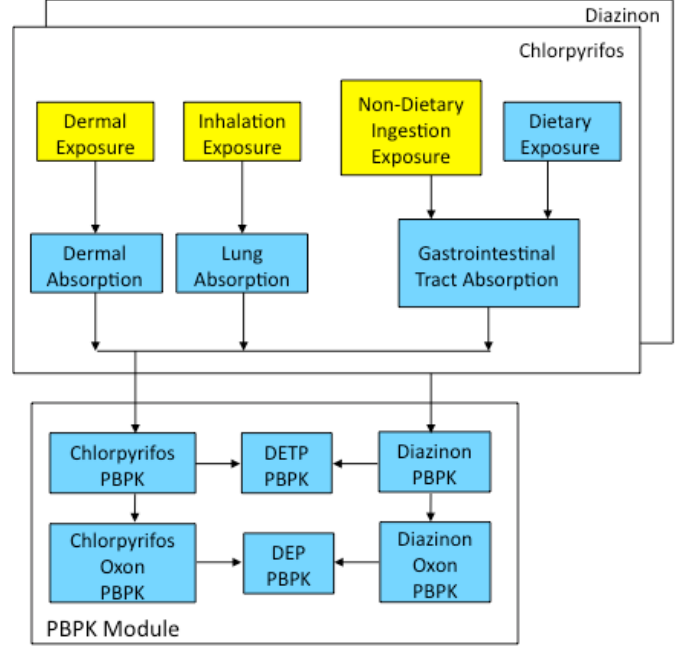
Figure 1. Child-Specific Aggregate Cumulative Human Exposure and Dose (CACHED) model framework including cumulative, aggregate and PBPK capabilities. Modules highlighted in yellow are from Cumulative Aggregate Simulation of Exposure (CASE)